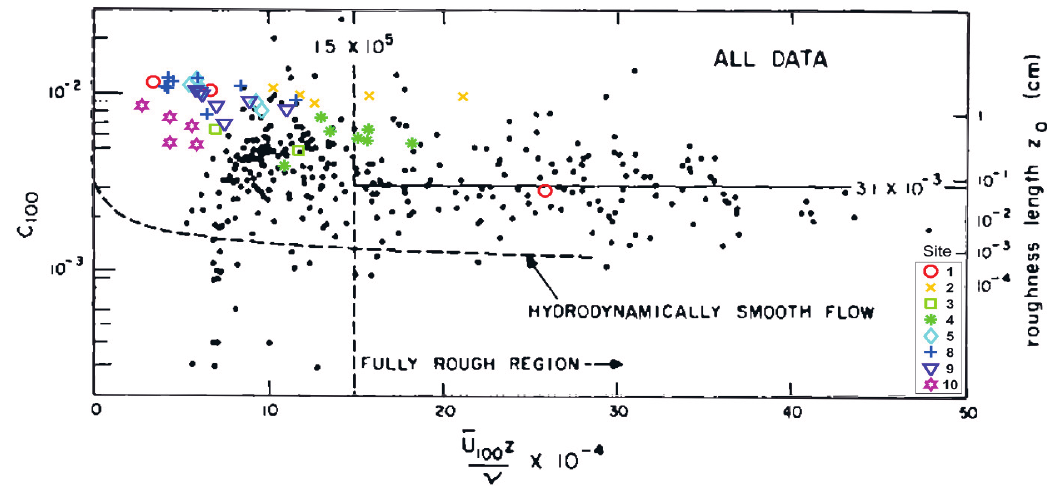
Figure 12. Comparison with Zo values from Sternberg [34] in various locations within Puget Sound [1] (modified from Sternberg [34]). The Reynolds number used for this graph is measured at 100 cm above the seabed (sea axis